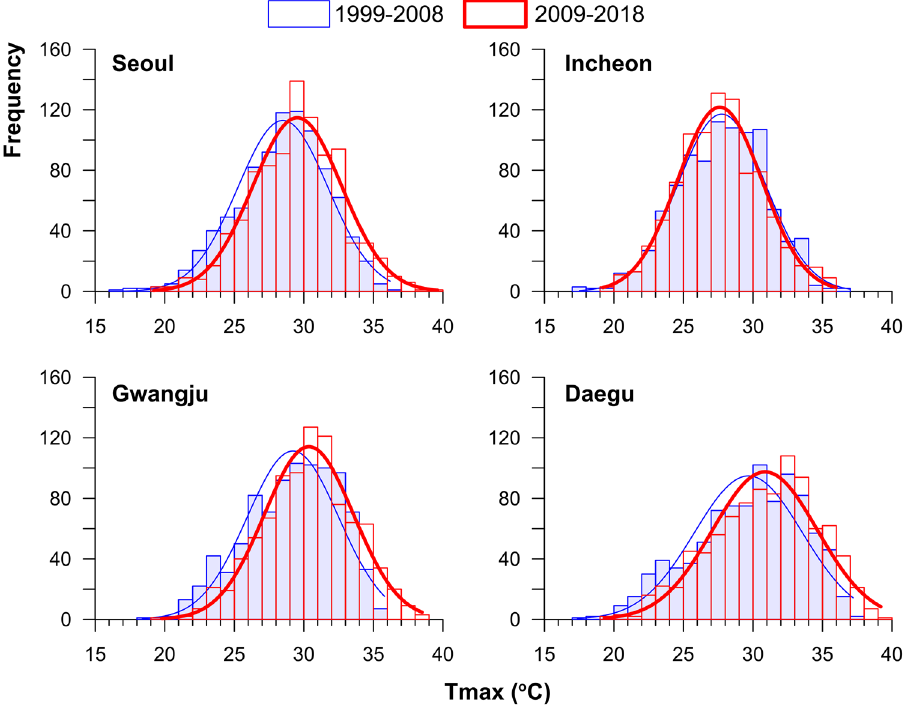
Figure 1. Comparison of the distribution of the Tmax during the summer (JJA) between the past (1999–2008) and the recent